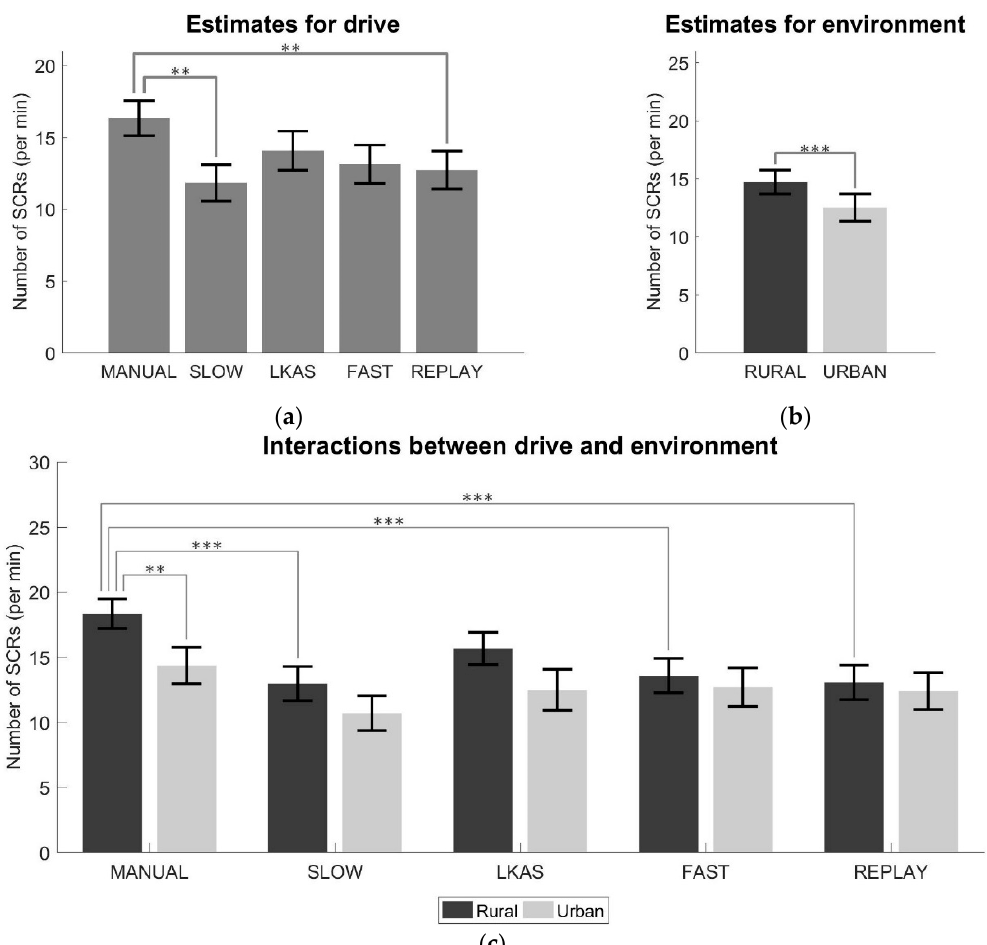
Figure 4. Number of skin conductance responses (SCRs) per minute (nSCR/min) for: ( a ) each drive; ( b ) across different environments; ( c ) and interaction effects. ** p ≤ 0.01, *** p ≤ 0.001. Error bars denote s.e.